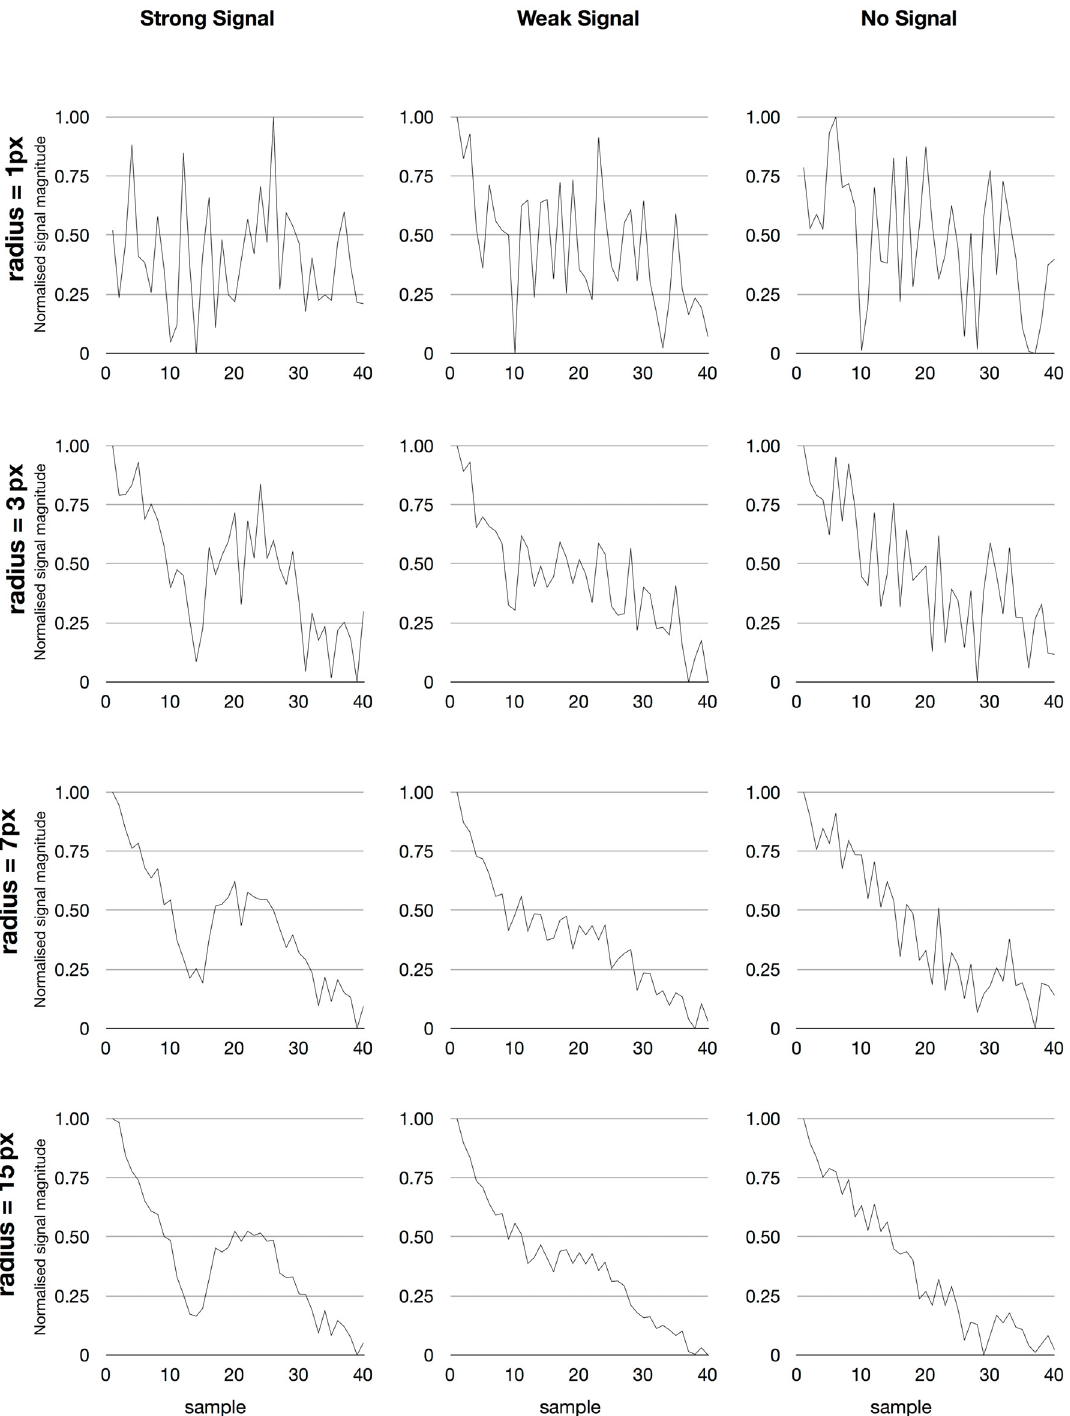
Fig 1. The result of spatial filtering of the recorded signal in a single pixel. The signal in an individual pixel for a single image sequence is very noisy but after spatial filtering the difference between a response and background can clearly be seen. Note that spatial smoothing is used to reveal temporal structure in the signal. The graphs are normalised to more clearly show the result and the filter radius is indicated in pixels. Left. A pixel with a strong response. The response is clearly revealed when a larger area is weighed together. Middle. A weaker signal can only been seen after substantial smoothing. Right. A pixel without a response. Spatial smoothing gradually approximates the bleaching